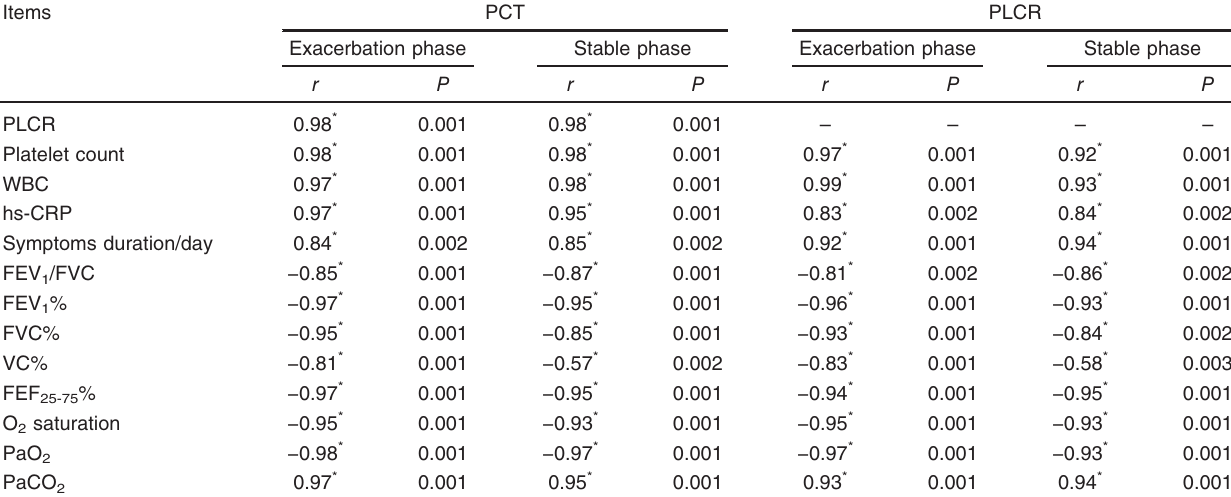
Table 3 Correlation of mean platelet volume and platelet distribution width with other studied variables during exacerbation phase and stable phase Items